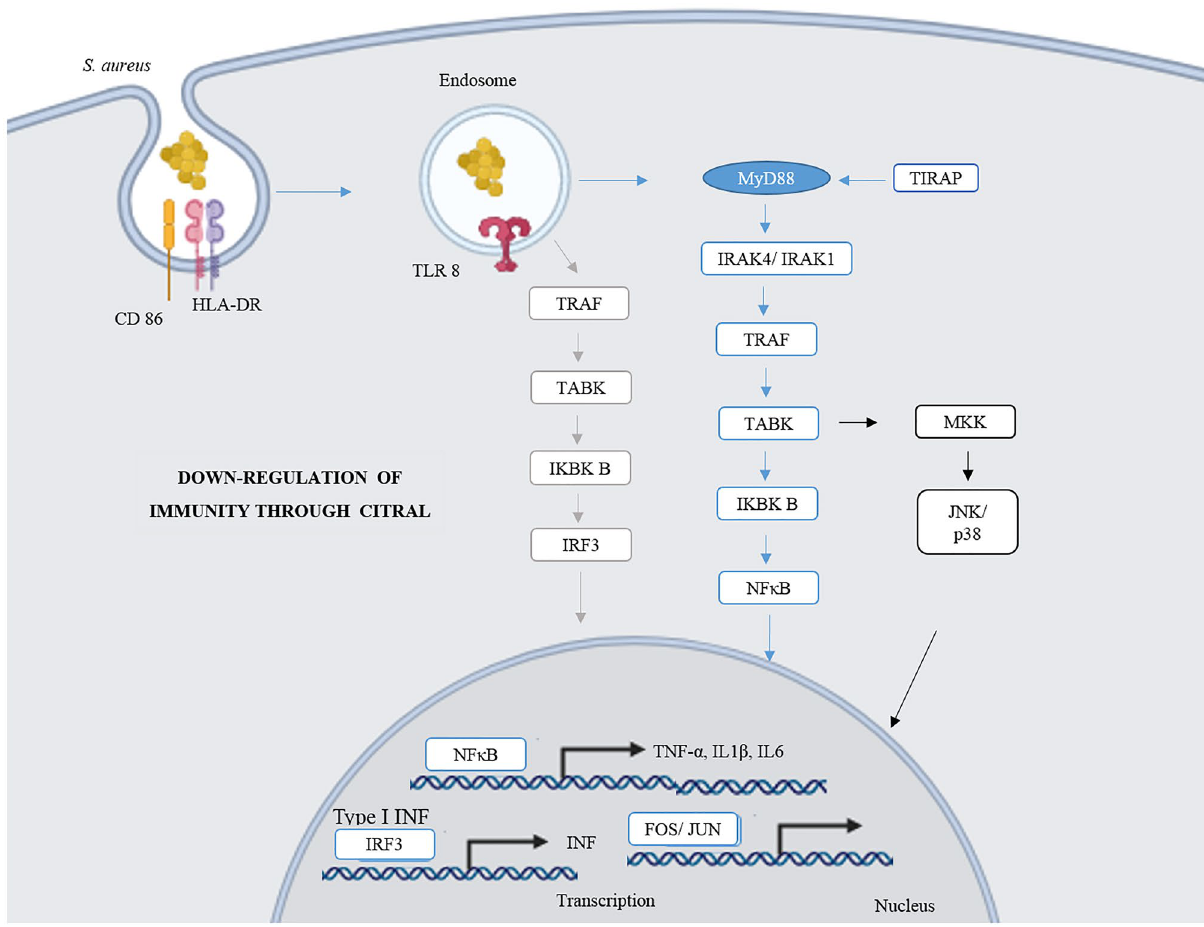
Figure 6. Citral provoked different intracellular responses in immune responses compared with those induced by Staphylococcus aureus . The study found actions on surface markers involved in recognition, presentation and migration, such as: CD14, CD54, CD80, CD282 and HLA-DR, global negative regulation of inflammation with inhibitory effects on NF- κ B, JNK/p38, and INF pathways, consequently reducing expression of cytokines IL-6, IL-12p70, and TNF-α (images: